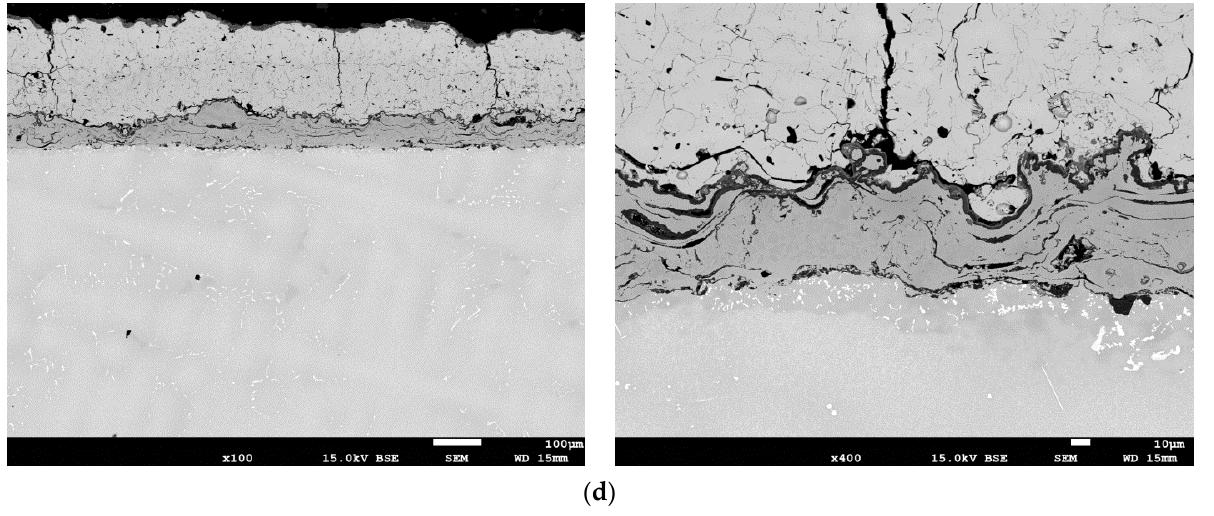
Figure 15. The structure of the protective coatings in the longitudinal section of the C–C blade (see Figure 2) made by the methods: ( a ) APS; ( b ) APS + SLURRY; ( c ) APS +VPA; ( d ) APS + TBC.